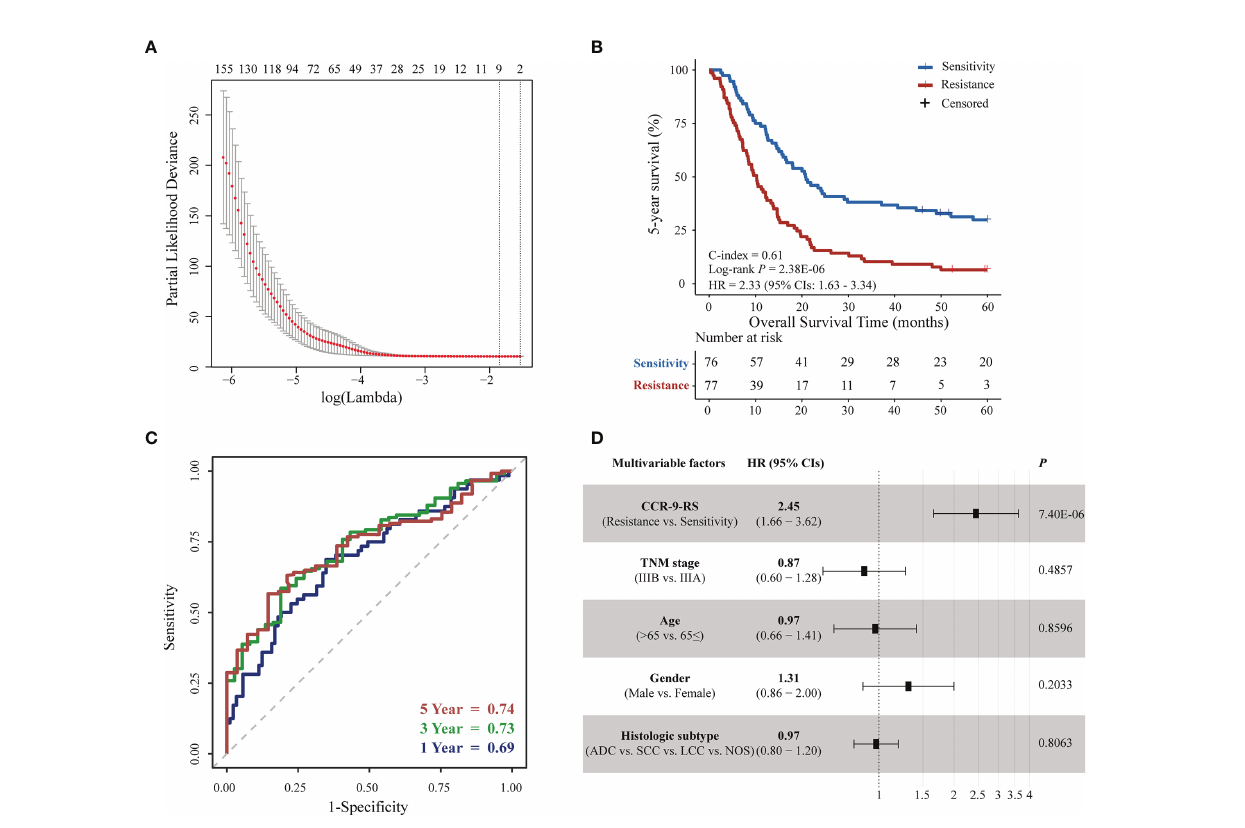
FIGURE 2 | Feature selection and survival analyzes for patients with NSCLC receiving CCR in the discovery dataset. (A) Tuning parameter ( l ) selection in the least absolute shrinkage and selection operator (LASSO) Cox model used a 10-fold cross-validation via minimum criteria. The area under the receiver operating characteristic (AUC) curve was plotted versus log( l ). (B) Kaplan – Meier curves of the 5-year survival rate for 153 patients. (C) Time-dependent receiver operating characteristic curve (ROC) of CCR-9RS in predicting the 1-, 3- and 5-year survival rates. (D) Multivariate Cox analyzes of CCR-9RS after adjusting for clinical factors.